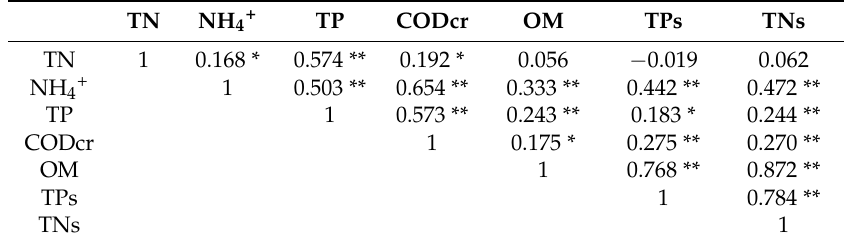
Table 3. Pearson correlation coefficients for TN, TP, CODcr, NH 4+ in surface water and TN, TP, OM in the surface sediment. TN NH 4+ TP